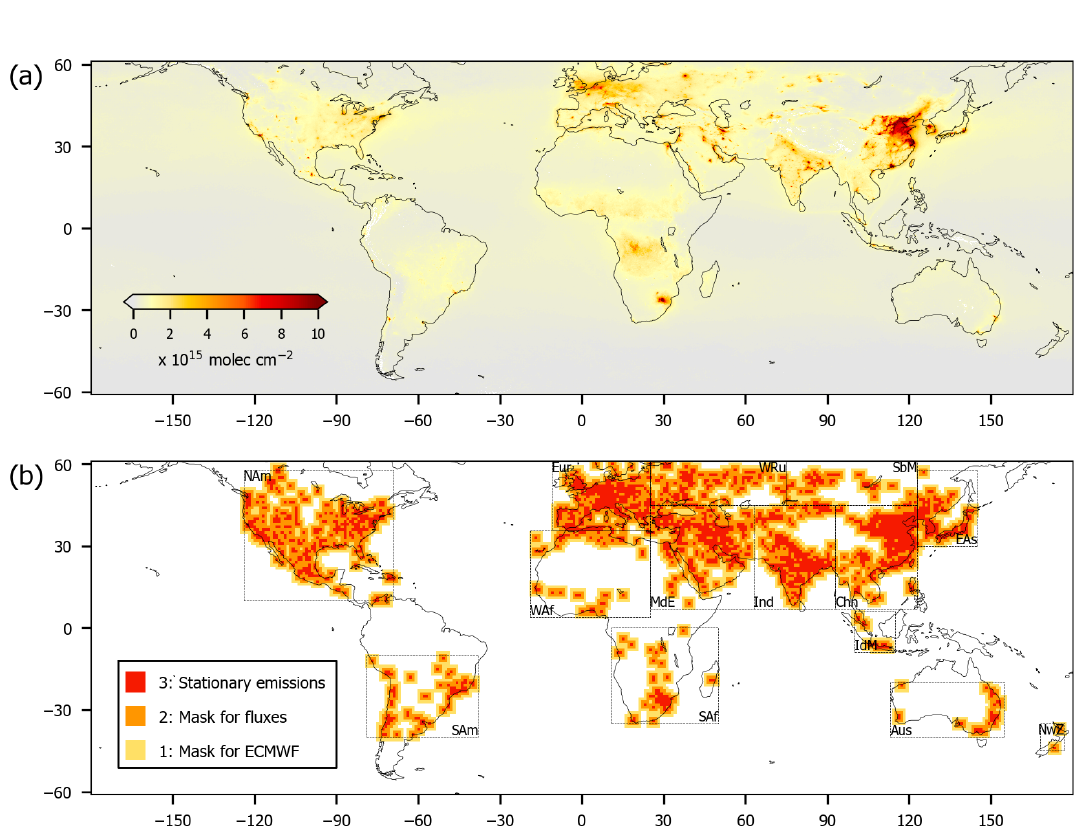
Figure 1. (a) Mean tropospheric NO 2 column density for 2019. (b) Mask M for the selection of pixels investigated in this study. The construction of M is described in the Supplement. Boxes indicate the regions as defined in Table 2.